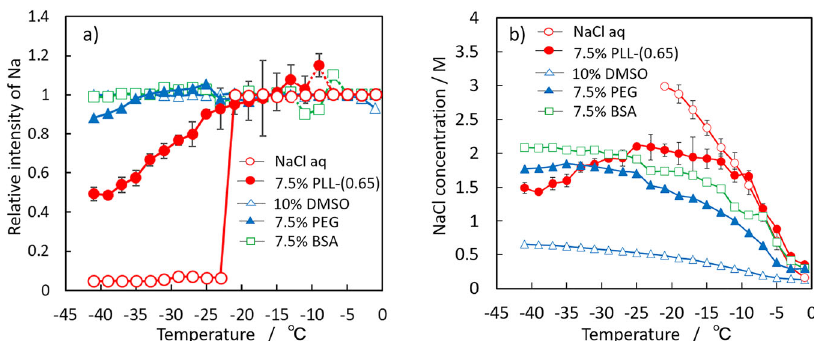
Fig. 5 Temperature dependent Na ion intensity and NaCl concentration in various CPA solutions. Temperature dependences of a Na-ion signal intensities and b NaCl concentrations calculated for various CPA solutions. The relative intensity values of the polymer solution in panel a above − 15°C are connected by dotted lines because it is dif fi cult to separate the two components and there is a large degree of variation. Error bars represent